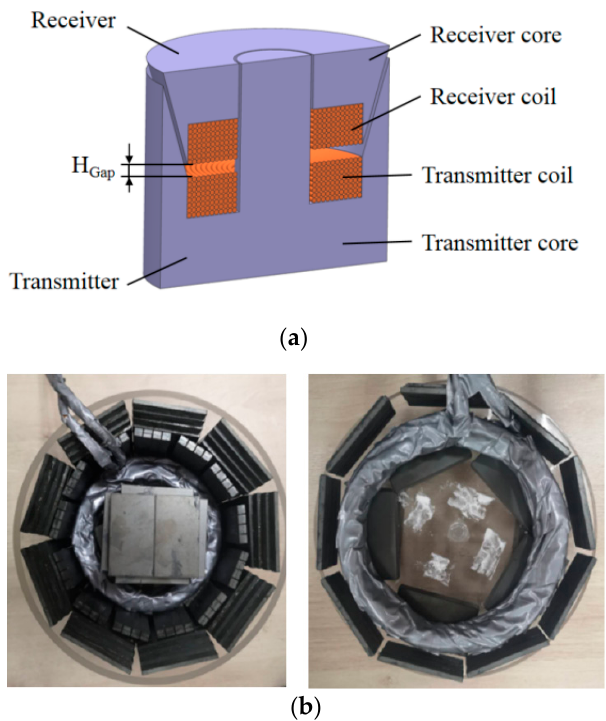
Figure 10. Proposed coupler structure: ( a ) basic structure; ( b ) prototype. Table 1. Component third harmonic as a variation of coupling